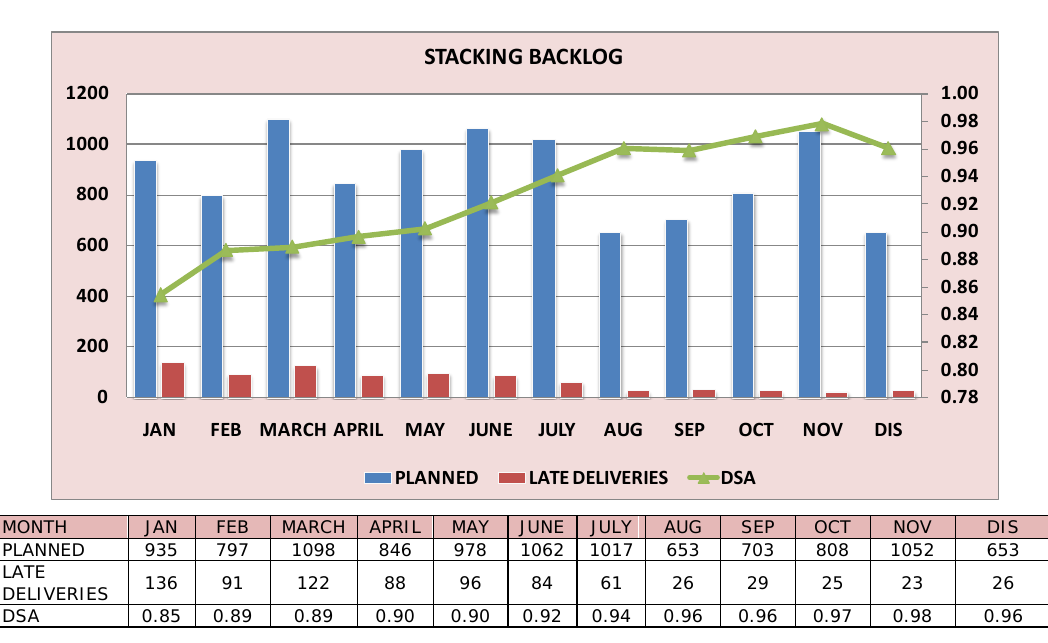
Figure 18. “Delivery Schedule Achievement on kitting department